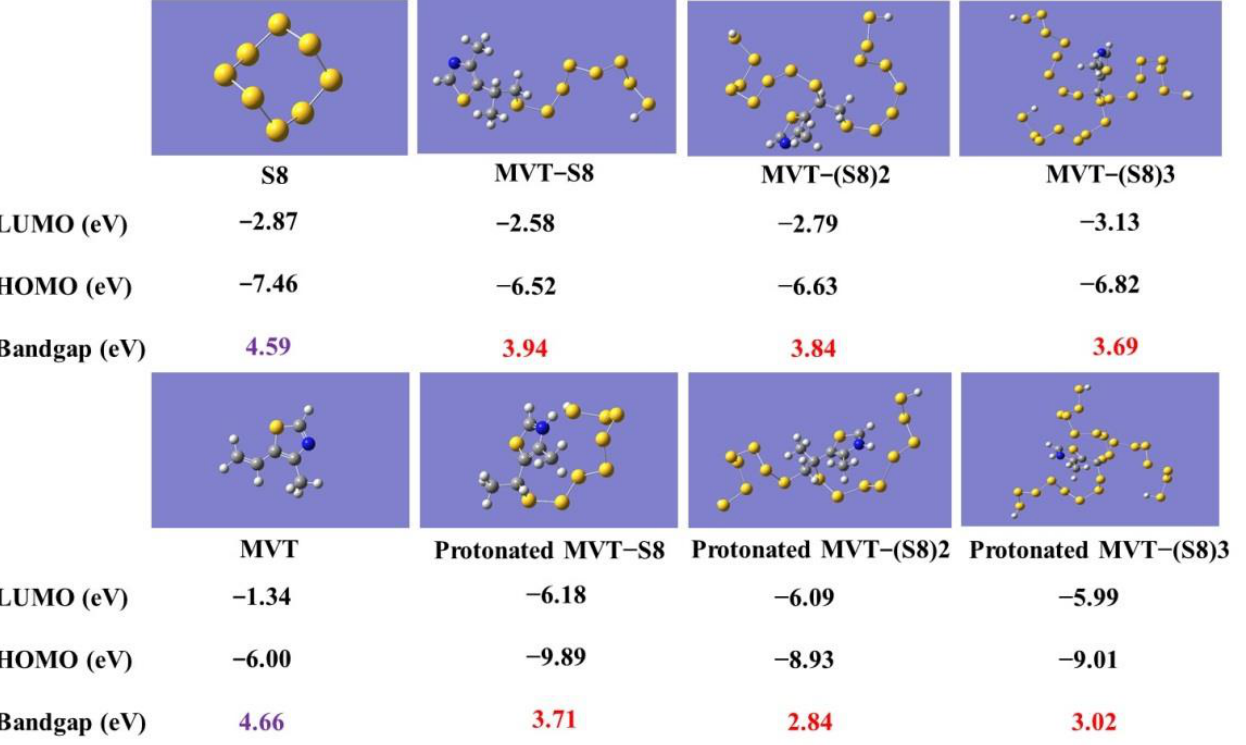
Figure 7. HOMO – LUMO bandgaps of elemental sulfur (S8), MVT, and poly(S-MVT)s with differ- Figure 7. HOMO–LUMO bandgaps of elemental sulfur (S8), MVT, and poly(S-MVT)s with different polysulfide chains ent polysulfide chains (-S8-). The band gap of MVT is 4.66 eV, which decreases greatly as a result of (-S8-). The band gap of MVT is 4.66 eV, which decreases greatly as a result of the polysulfide chain the polysulfide chain attachments.